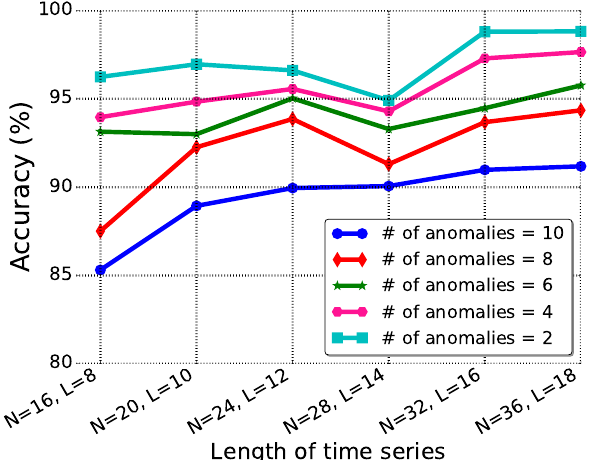
Figure 7. Detection accuracy for different length N .